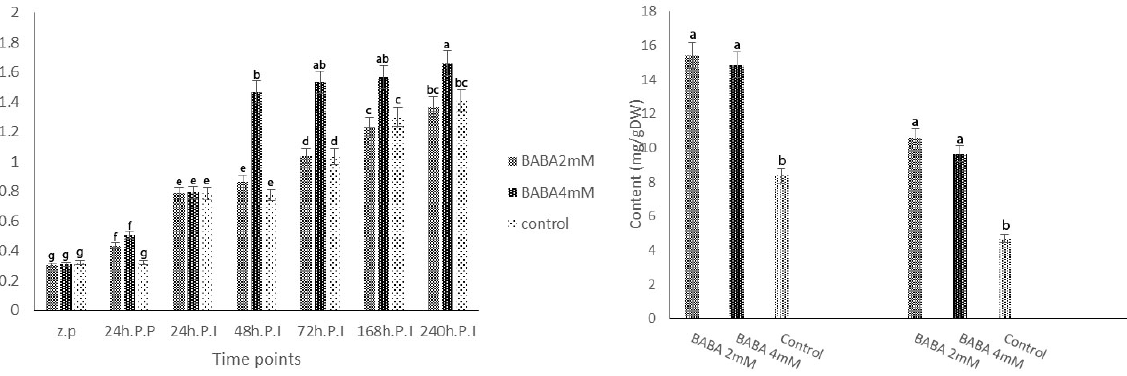
Fig. 7: Effect BABA pretreatments on the Guaiacol peroxidase (GPX) ac- tivity. Mean comparison of GPX activity of treated squash plants using Duncan method at a P < 0.01 significance level. Different let- ters show a significant difference. Z.P; time point 0. 24 PP; 24 h post priming. hpI; hours post inoculation. Standard bar showed dif- ferences at α = 0.5%.